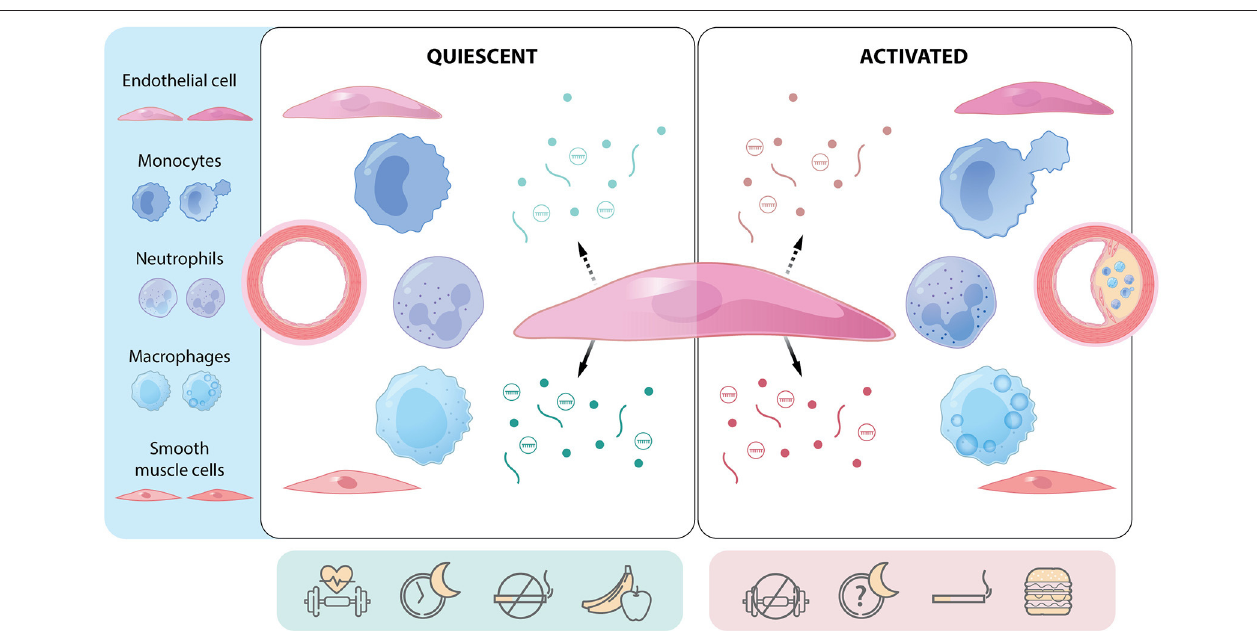
FIGURE 1 | The endothelial cell as a communication hub in quiescent and activated states. Central endothelial cell with apical (hatched arrow) and basolateral (solid arrow) release of mediators [e.g., proteins (lines), gases and small molecules (dots), extracellular vesicles (circles containing cargo)]. Communication differs depending on whether the endothelium is quiescent or activated (e.g., regions prone to atherosclerosis) and can affect several cell types. Endothelial function and communication are affected by several lifestyle factors such as physical activity, sleep hygiene, smoking, and diet. Atherosclerotic plaque development is a function of cellular communication and represents a multicellular response to environmental, genetic, and epigenetic cues. Green: mediators and factors that actively maintain endothelial quiescence. Red: mediators and factors that promote endothelial